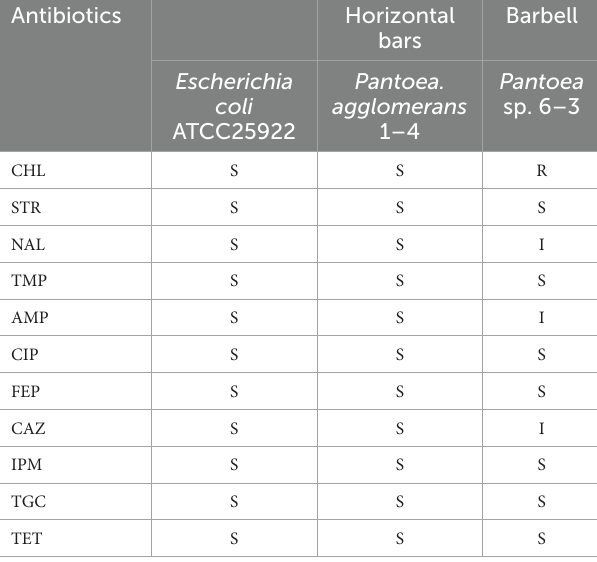
TABLE 3 Antimicrobial susceptibility test of Pantoea